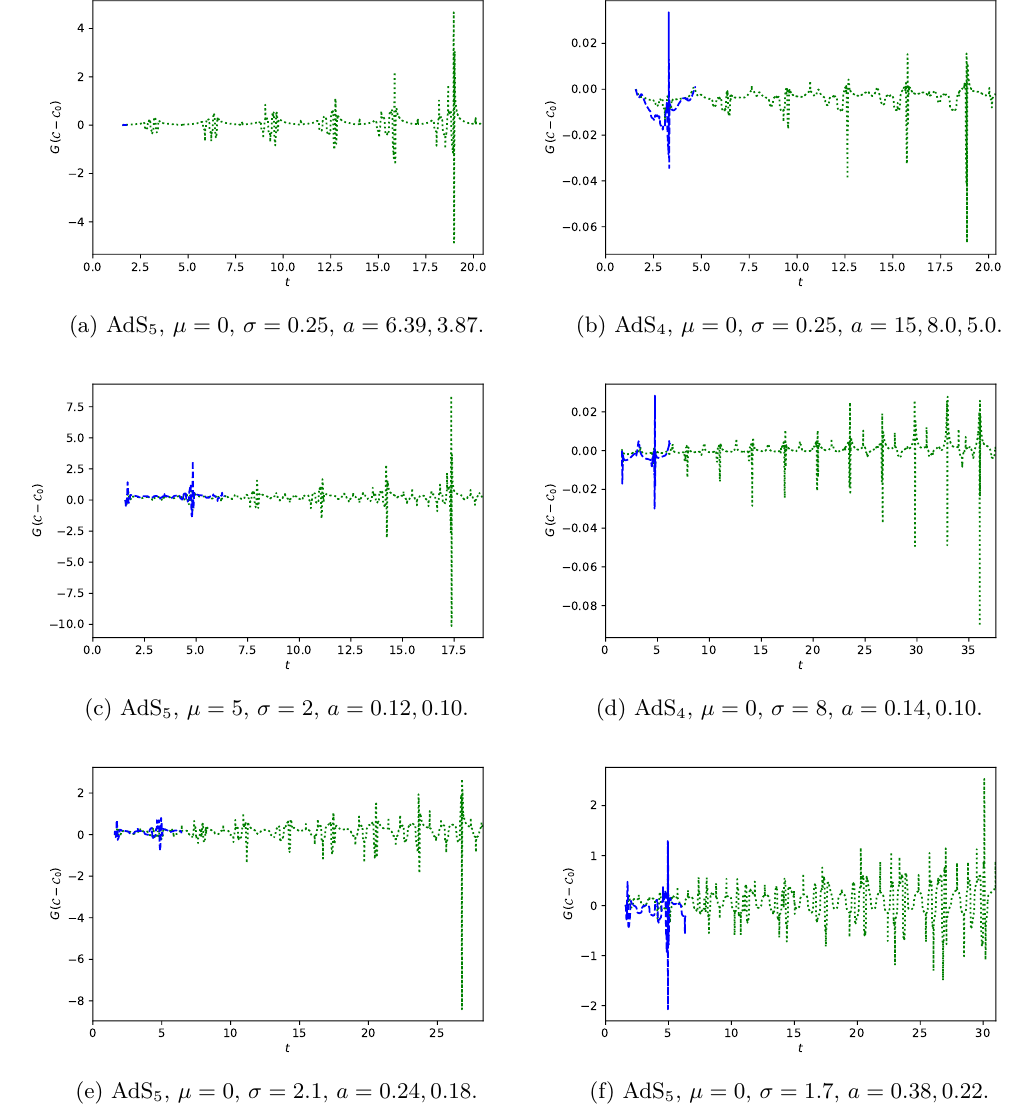
Figure 5. Rescaled action complexity for listed initial data in AdS 4 and AdS 5 . Curve for the larger amplitude in each figure is dashed blue, smaller is dotted